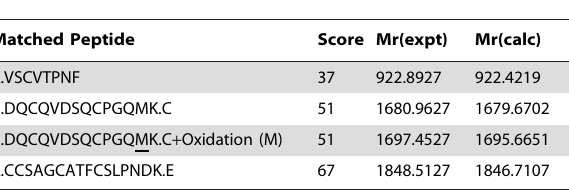
Table 1. Identified Peptides of HE-4 by LC-MS/MS.